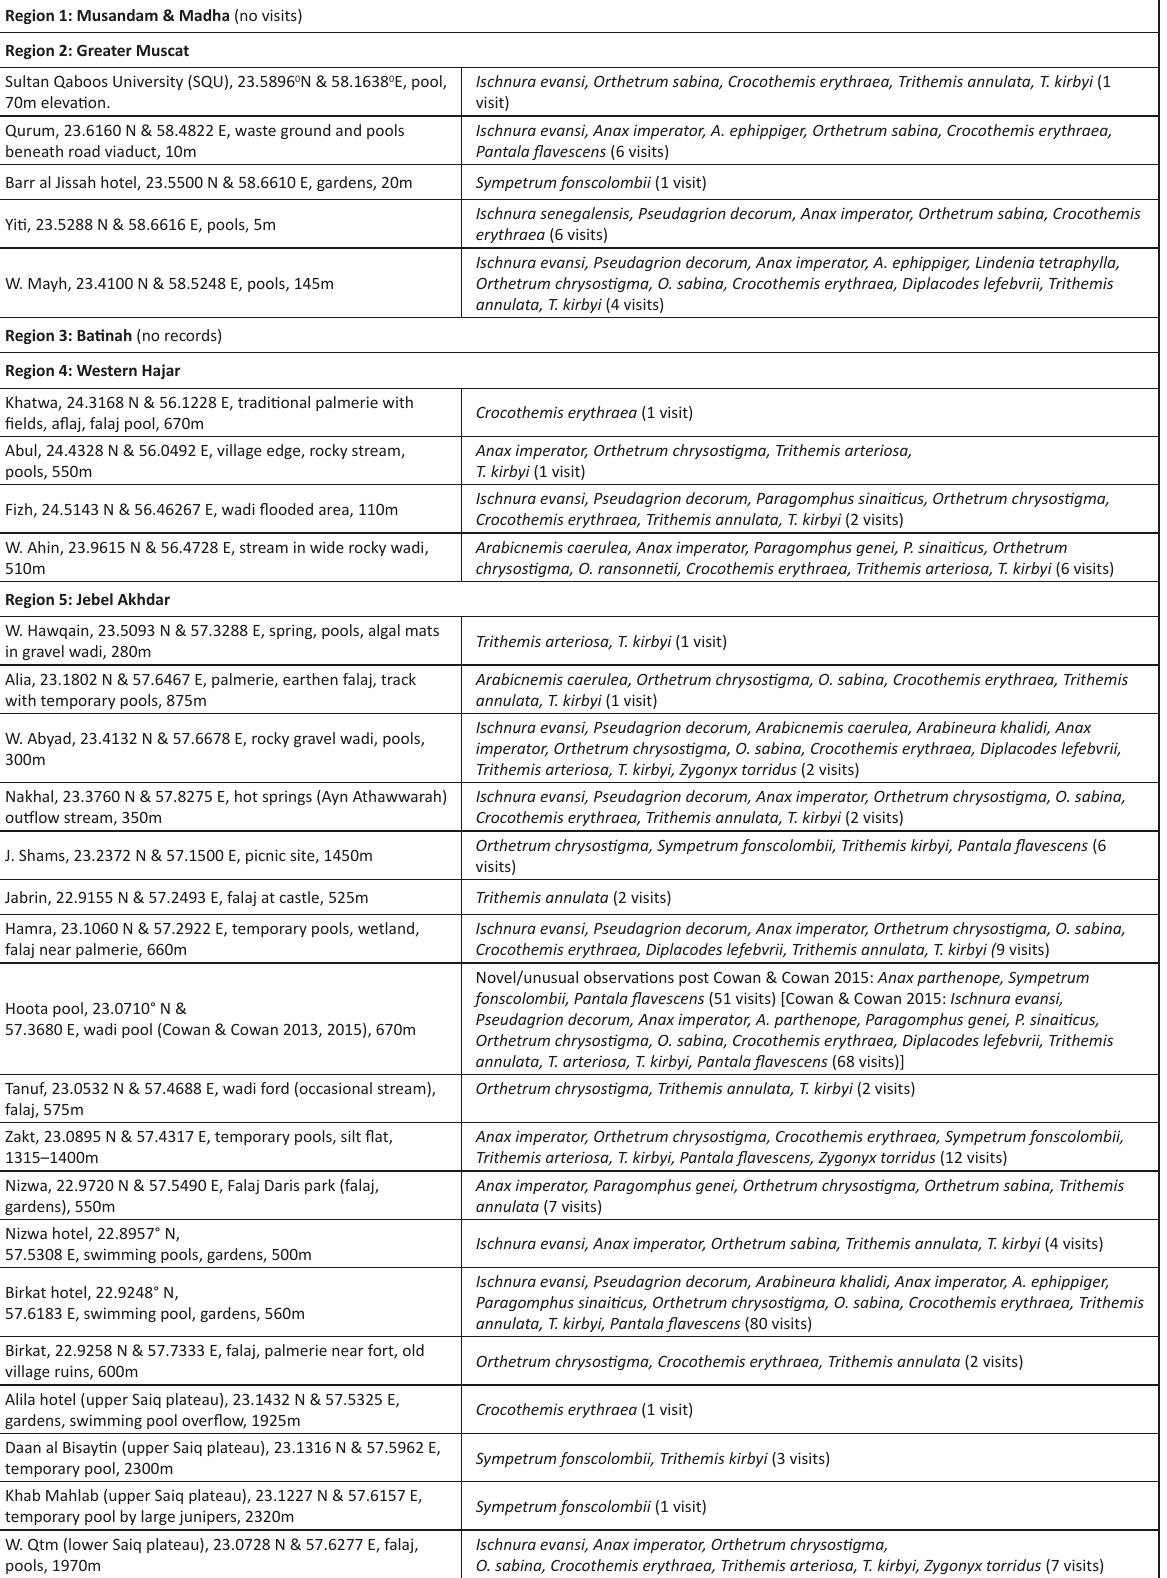
Table 2. Sites in northern and central Oman, organised by geographic region, at which the authors recorded odonates. The right-hand column presents the odonate species recorded by the authors at the site and number of visits. J. = Jebel, W. = Wadi. Region 1: Musandam & Madha (no